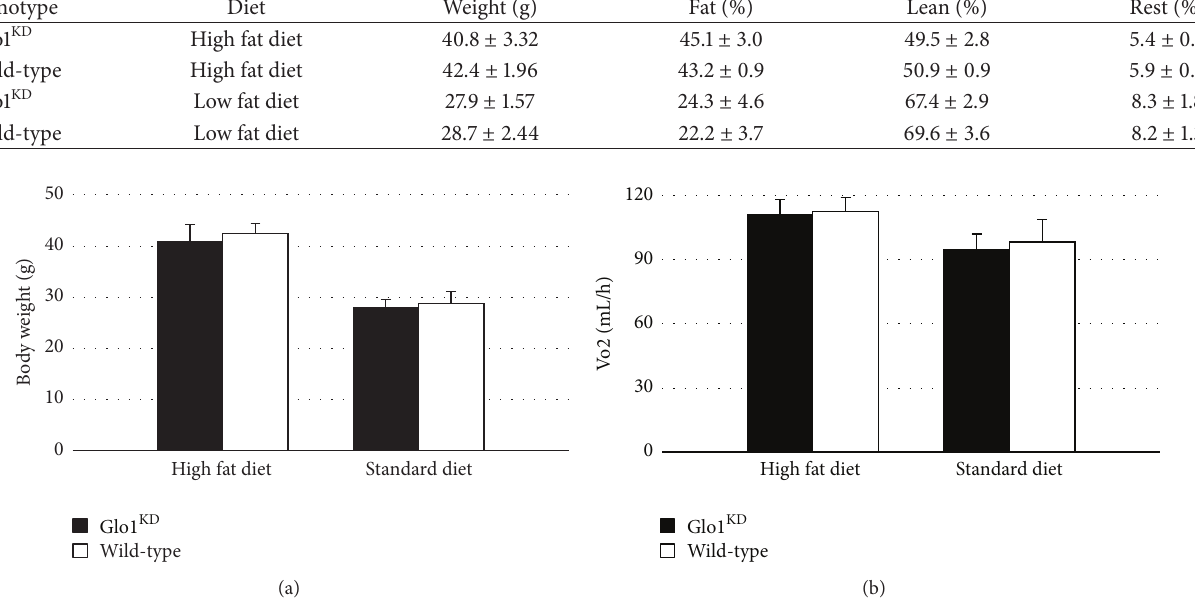
versus 42.4 ± 1.96 g, 𝑝 = 0.379 ; Glo1 KD versus wild-type, high fat diet: 27.9 ± 1.57 g versus 28.7 ± 2.44 g, 𝑝 = 0.547